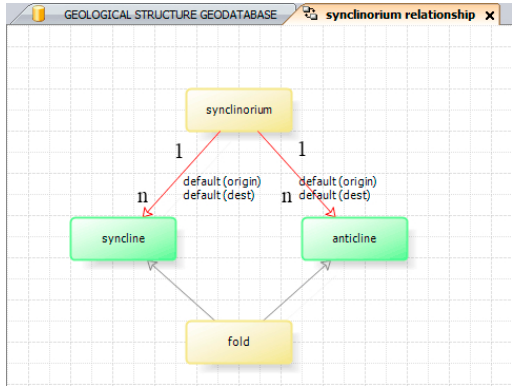
Figure 8. Association rule of a synclinorium.